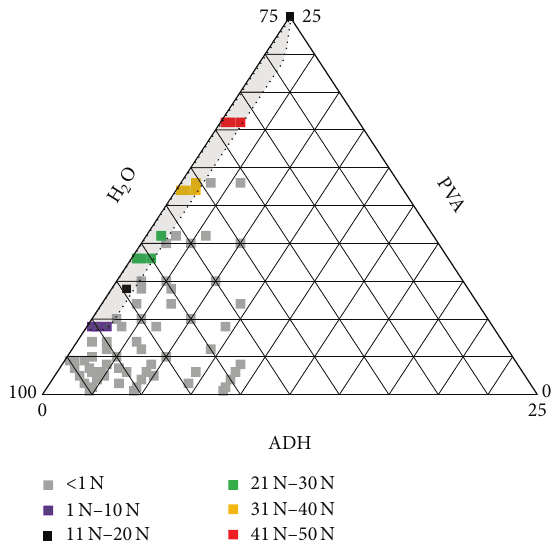
Figure 7: Ternary phase diagram of gel strength as a function of the ratios of the 3 components composing PVA hydrogel and ratios of gelation were observed in the shaded